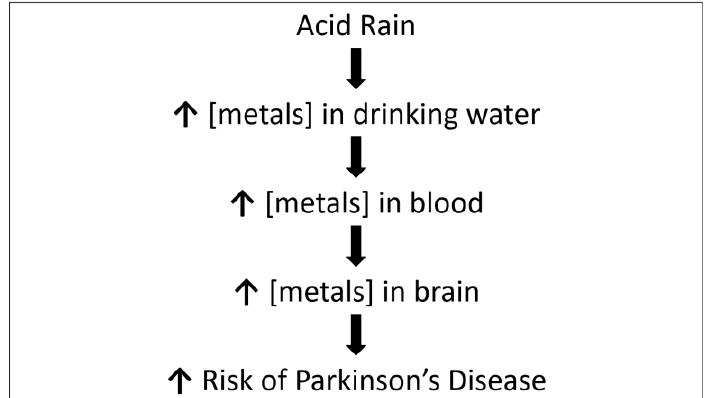
Figure 2. Hypothesized biological model of the acid rain hypothesis, “[]” indicates concentra- tion.